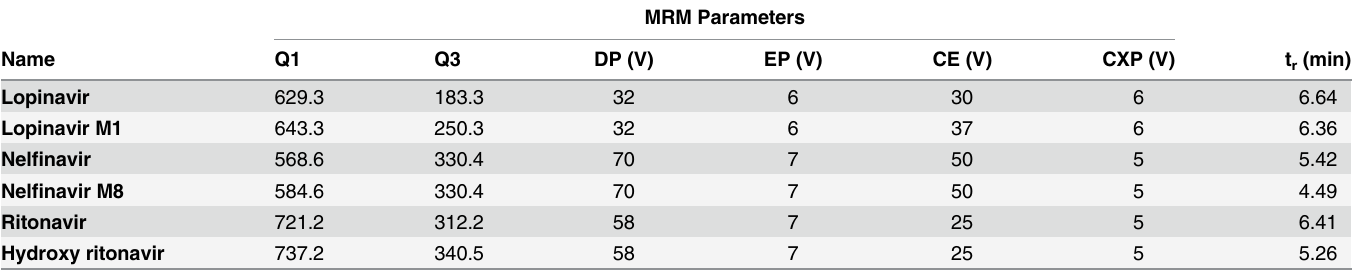
Table 1. Summary of optimized parameters and characteristics for positive mode LC — MS/MS detection of Protease